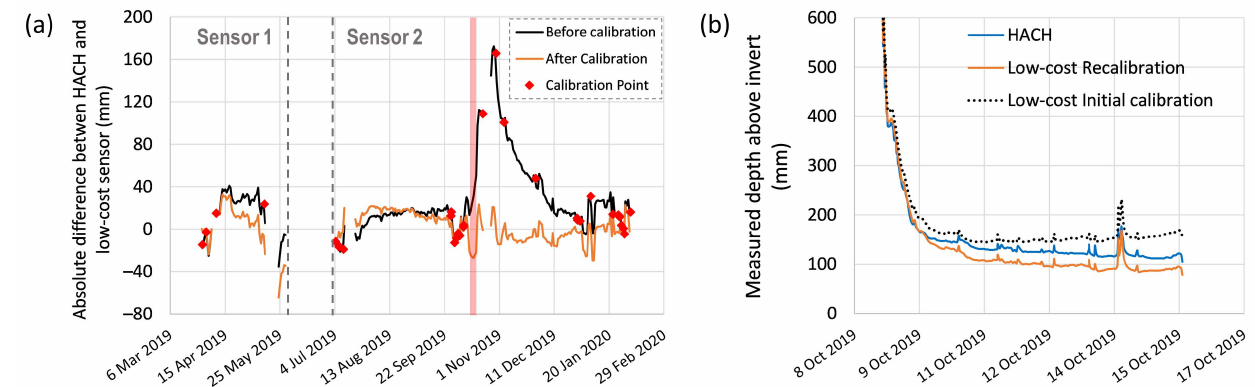
Figure 7. ( a ) averaged daily difference between low-cost water depth sensor and HACH submerged probe for both low-cost Sensor 1 and Sensor 2—The positive difference represents the low-cost water depth is higher than that of HACH probe; ( b ) the measured water depth of low-cost Sensor 2 and HACH submerged probe during the red-shaded